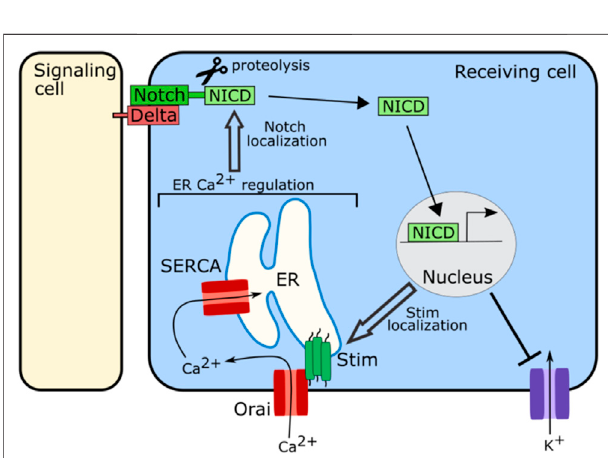
FIGURE5| Schematic ofroleofionchannelsin Notch signaling.The ion channels involved in regulating calcium levels in the ER including SERCA, Stim, and Orai, are required for proper localization of Notch at the cell membrane to participate in signaling. Notch signaling in turn regulates the localization and clustering of Stim. Notch signaling also attenuates the activity of potassium channels.